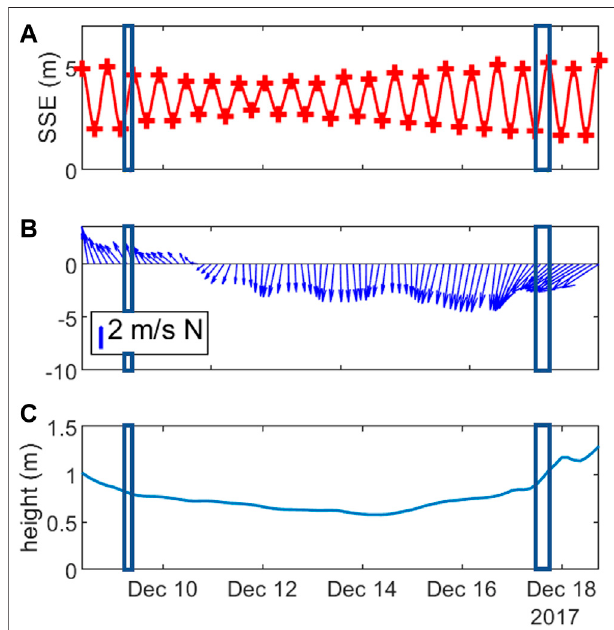
FIGURE2| Timeseries ofoceanographicand meteorologicalconditions during the December 2017 research cruise. Transects #5 and #21 were obtained during the times marked. (A) Timesofhigh and lowtidal elevation for Duya, Myanmar (Egbert and Erofeeva, 2002). (B) Wind vectors and (C) WaveheightsfromGFS(EnvironmentalModelingCenter,2003).Windvectors show direction toward which the modeled wind